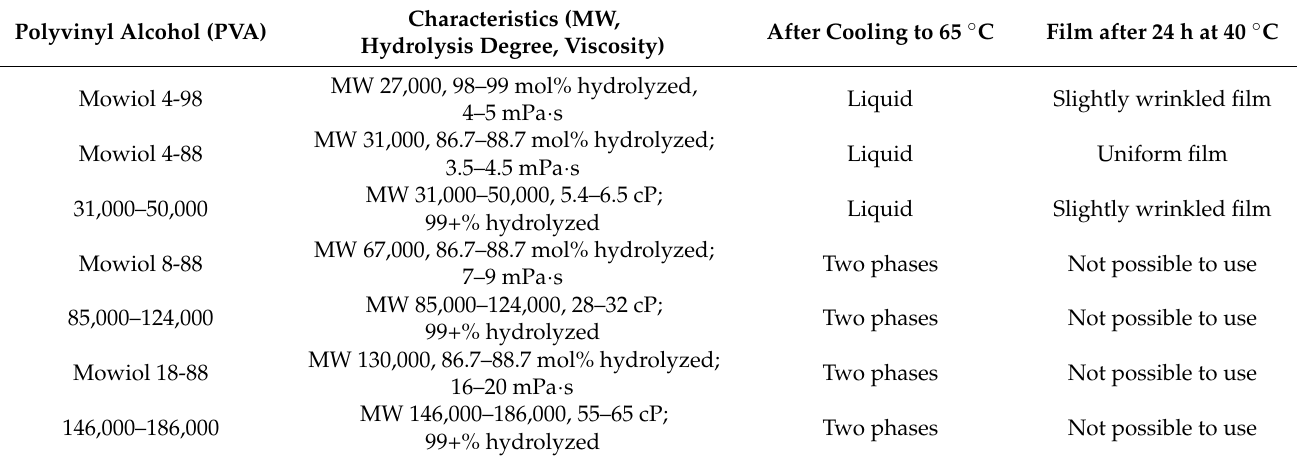
Table 1. Polyvinyl alcohols (Sigma-Aldrich) and their characteristics. Characteristics Polyvinyl Alcohol (PVA)